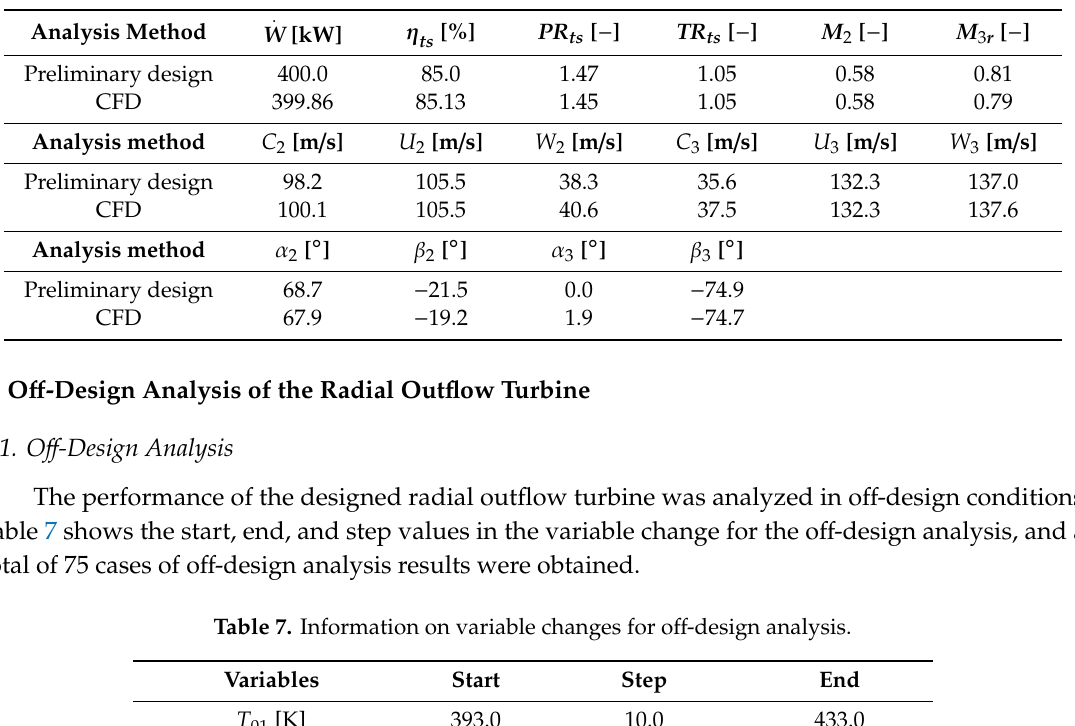
Figure 10. Comparison of velocity triangles between preliminary design and CFD. Table 6. Comparison of main results between preliminary design and CFD.